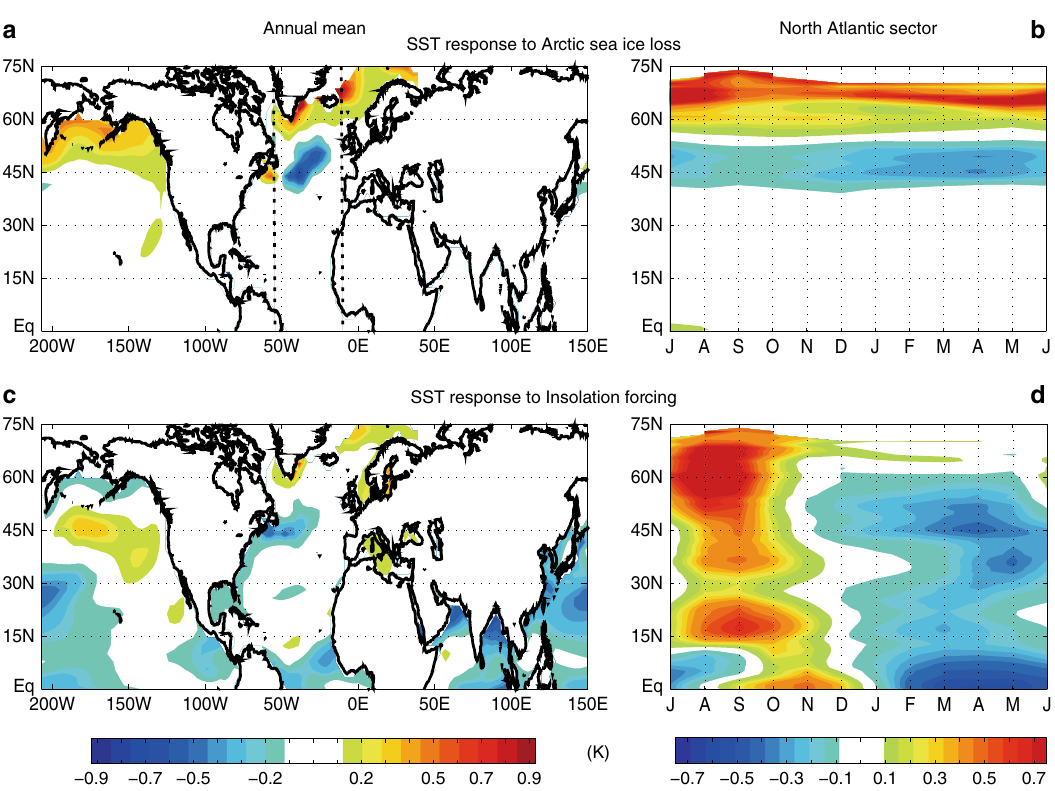
Fig. 4 Sea surface temperature responses to Arctic sea ice loss and insolation. The SST response to mid-Holocene a , b Arctic sea ice loss and c , d insolation forcing. a , c The annual-mean surface air temperature anomalies (K) and b , d zonally averaged (55° – 10°W; North Atlantic sector), longitude – time Hovmöller plots of anomalous surface air temperature (K). The abscissa is time (months) and the ordinate is latitude. Dotted lines in a are longitudinal bounds for the Hovmöller